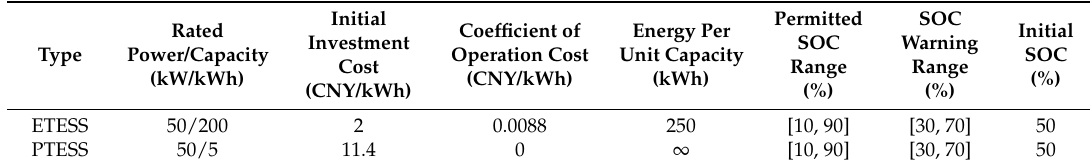
Table 4. Parameters of HESS.